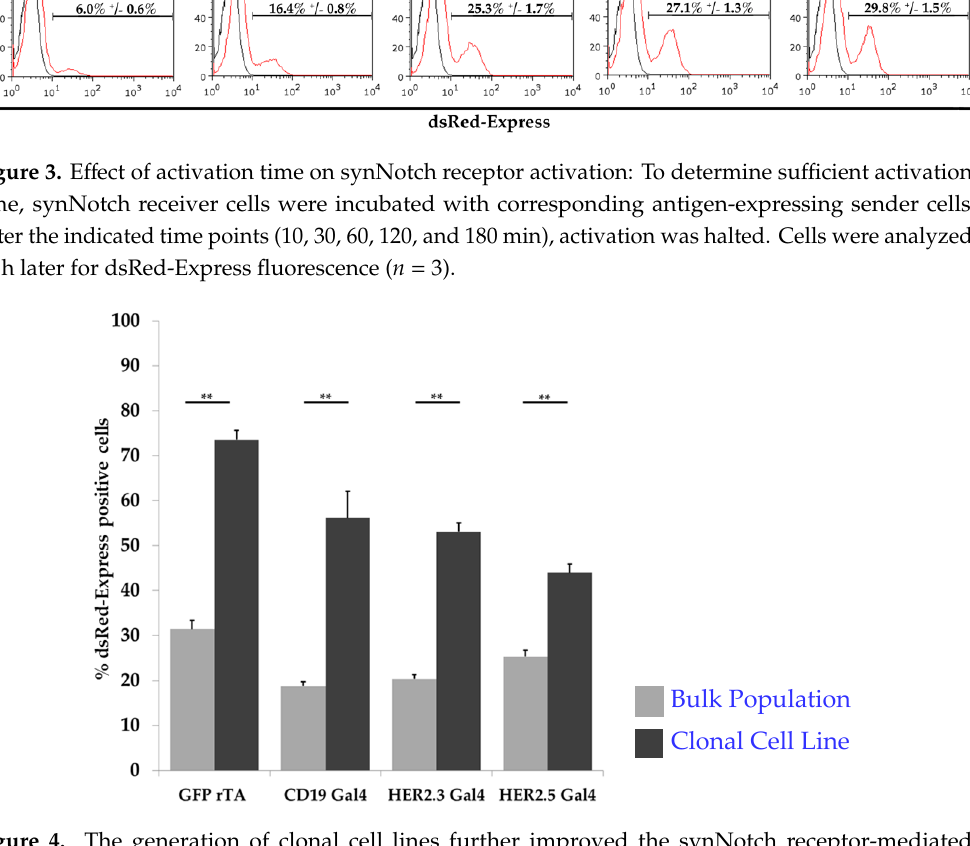
Figure 4. The generation of clonal cell lines further improved the synNotch receptor-mediated fluorophore expression of all four investigated synNotch receptor constructs under the same conditions (sender cell–receiver cell ratio 1:1, 60 min) ( n = 5,** p < 0.01).